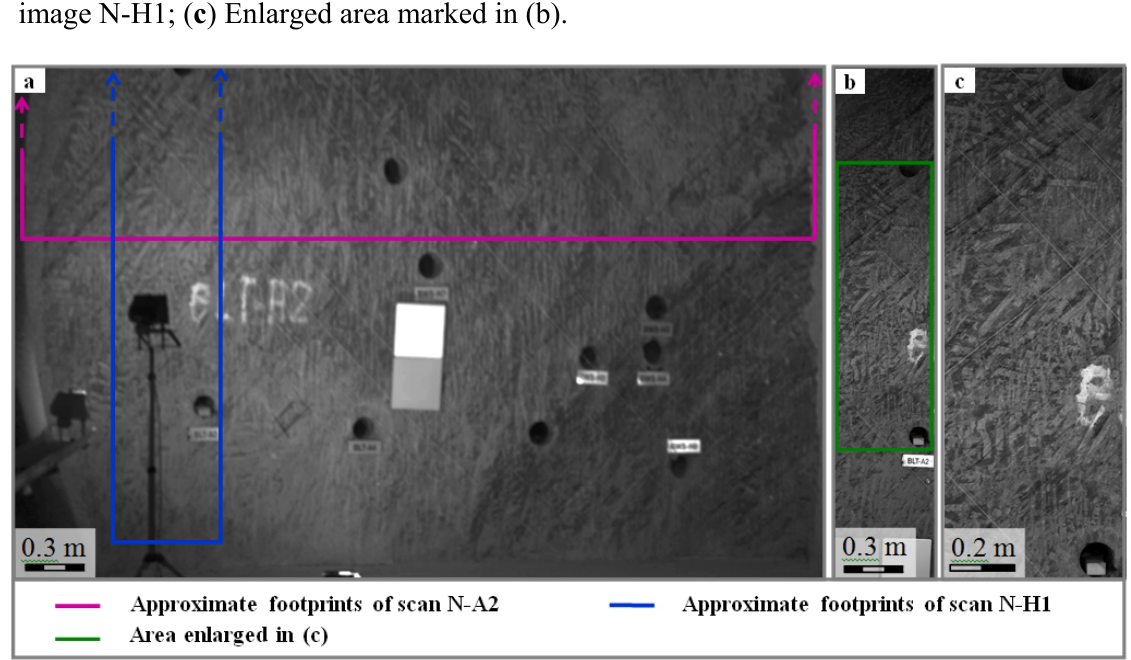
Figure 3. ( a ) Hyperspectral image N-A1, band 62: 1.634 µm; ( b ) Band 62: 1.634 µm of image N-H1; ( c ) Enlarged area marked in